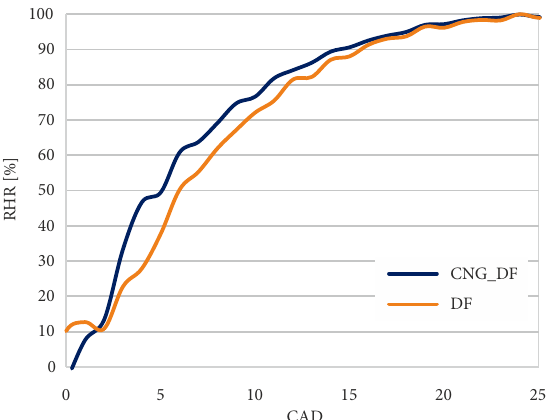
Figure 8. RHR at a 10% engine load Figure 9. RHR at a 50% engine load